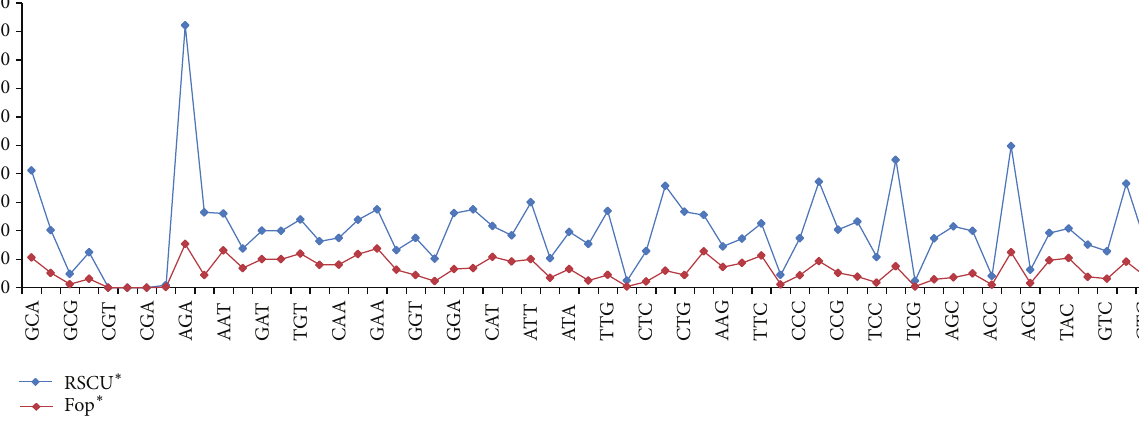
Figure 4: Trend of RSCU and Fop values in the coding sequences of the